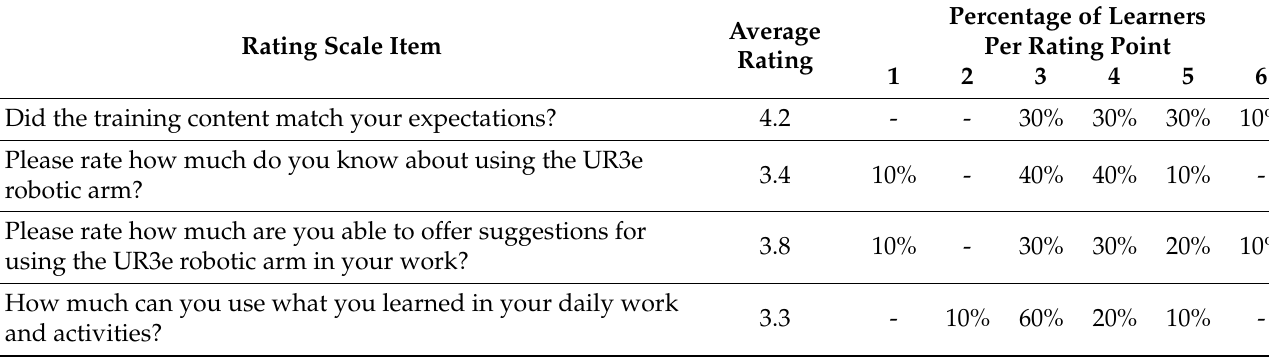
Table 4. Learners’ evaluation of the training course performance, multiple-choice item.